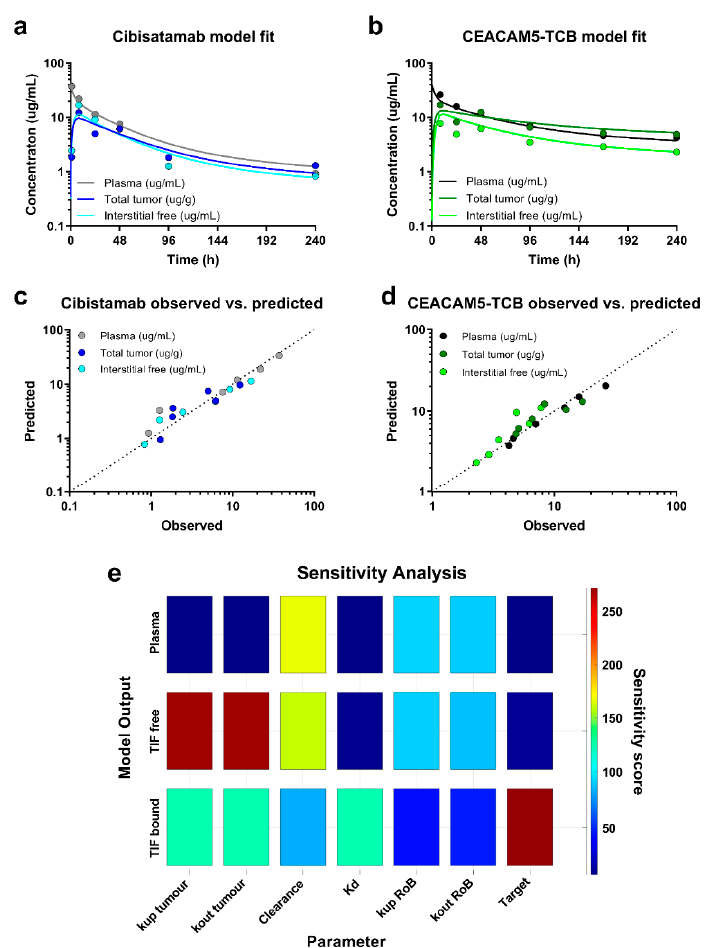
Figure 8. Model fitting and model performance assessment: Model fit to mean PK data measured in plasma-, total tumour tissue- and free interstitial fluid samples after a dose of 2.5 mg/kg for ( a ) cibisatamab and ( b ) CEACAM5-TCB. Further assessment of model performance based on observed vs. predicted plots for ( c ) cibisatamab and ( d ) CEACAM5-TCB and ( e ) a local sensitivity analysis for fitted PK readouts on estimated parameter (representatively shown for CEACAM5-TCB).